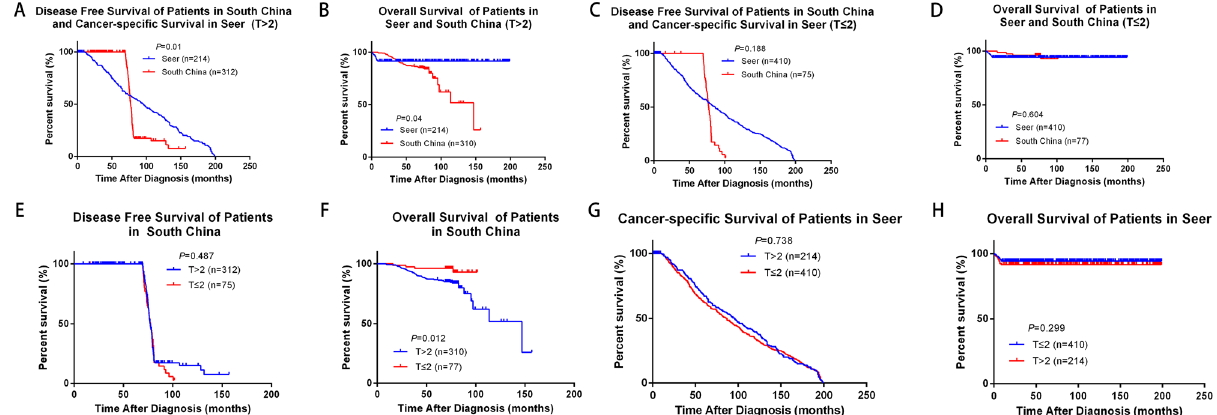
Figure 3. Comparison of different tumor size in Southern China and SEER database. ( A , B ) Kaplan–Meier estimates DFS or CSS and OS of patients whose T > 2 cm in both Southern China and SEER database, ( C , D ) Kaplan–Meier estimates DFS or CSS and OS of patients whose T ≤ 2 cm in both Southern China and SEER database, ( E , F ) Kaplan–Meier estimates DFS and OS of different tumor size in Southern China, ( G , H ) Kaplan– Meier estimates CSS and OS of different tumor size in SEER database.